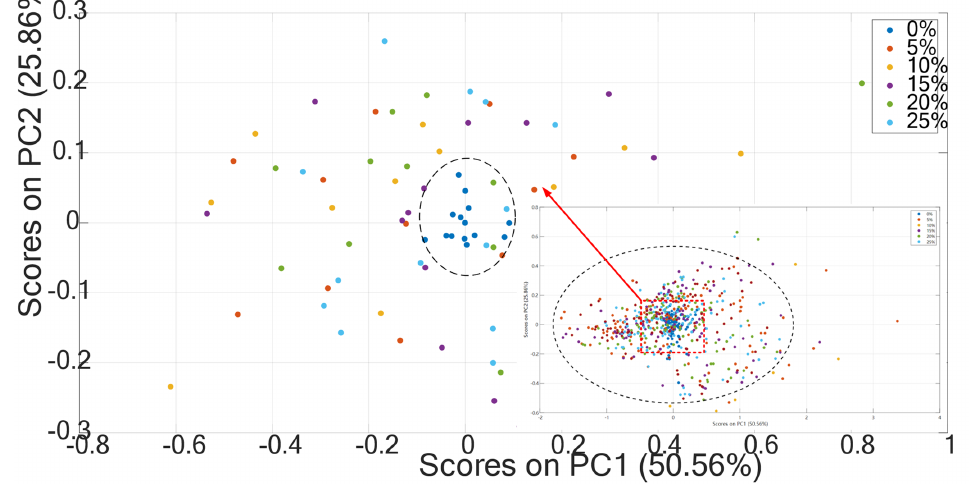
Figure 4. PC1 and PC2 scores after PCA for soil spectra at 0% (dry soil), 5%, 10%, 15%, 20%, and 25% moisture content.